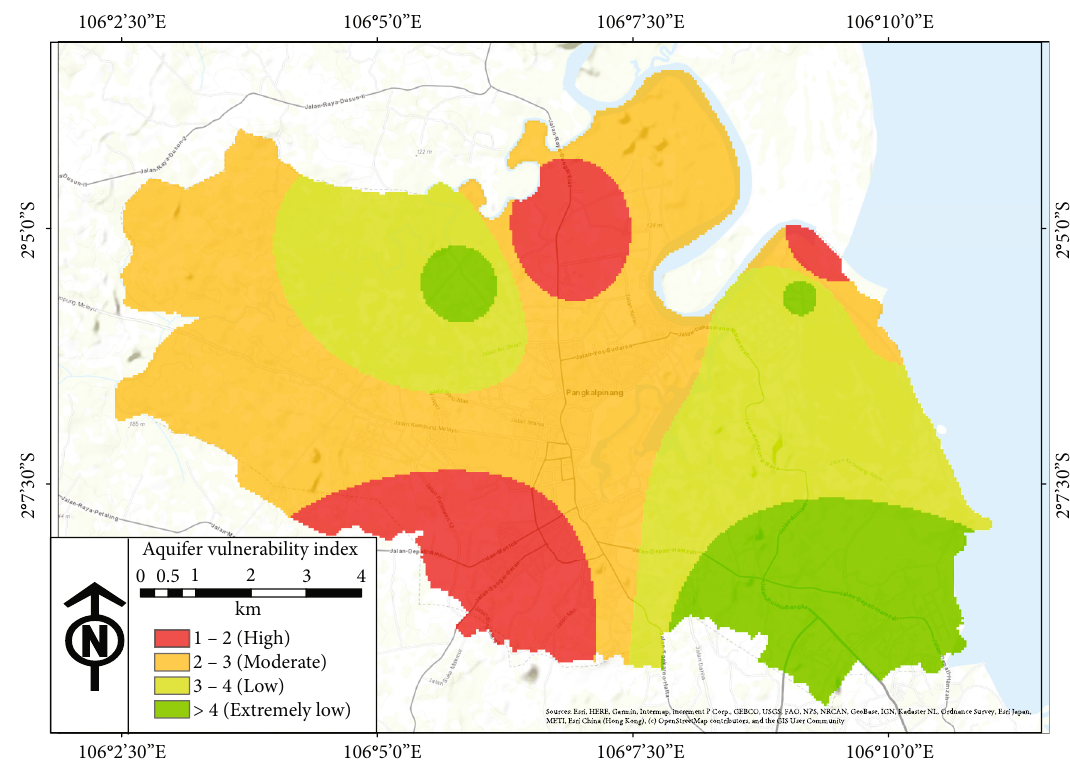
Figure 9: Aquifer vulnerability index in the study area. Table 8: Estimated geohydraulic parameters.